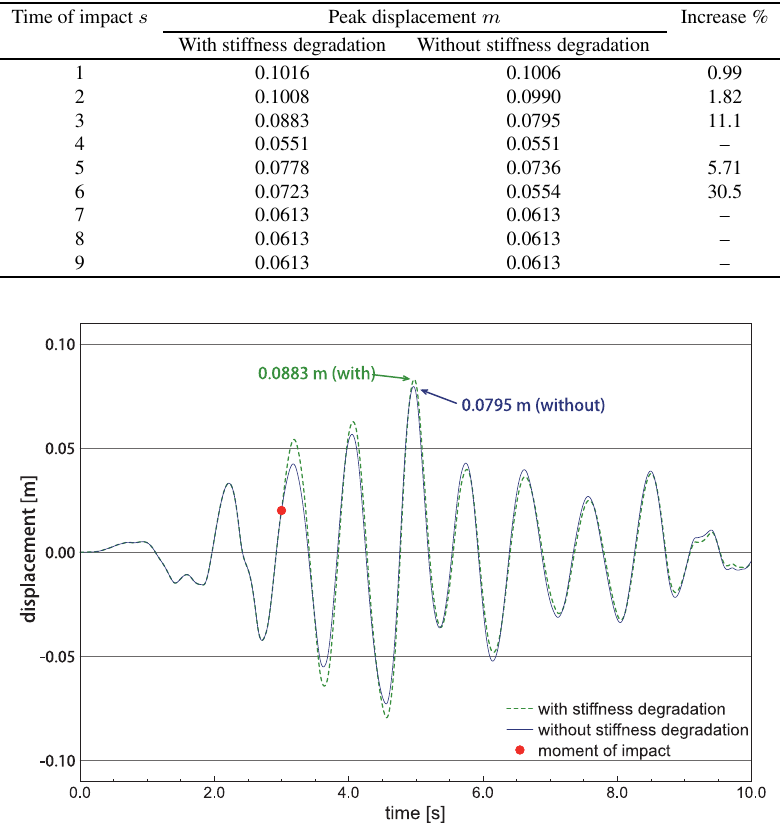
Fig. 7. Displacement time history of the first story of building under the El Centro earthquake with and without considering the degradation of horizontal stiffness for impact at t = 3 s. (see Fig. 3). The dynamic equation of motion formulated in Eq. (17) has been used taking M = M 1 + M 2 + M 3 , ¯ C = C 1 and K ( t ) determined according to Eq. (12). In this phase of the analysis, the constant value of the vertical force, F ( t ) = ( M 1 + M 2 + M 3 ) g ( g is the gravity acceleration), which results only from the weight of all floor slabs, has been